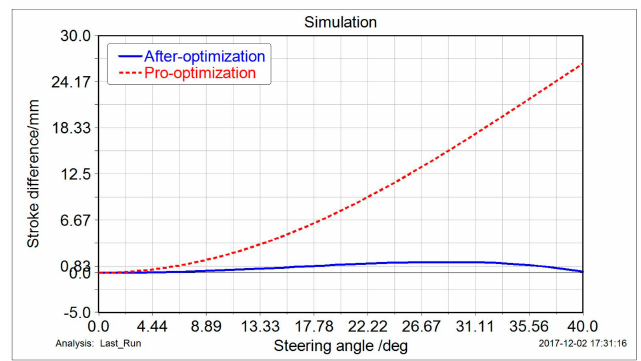
Figure 9. Comparison of steering hydraulic cylinder stroke between before and after optimization.